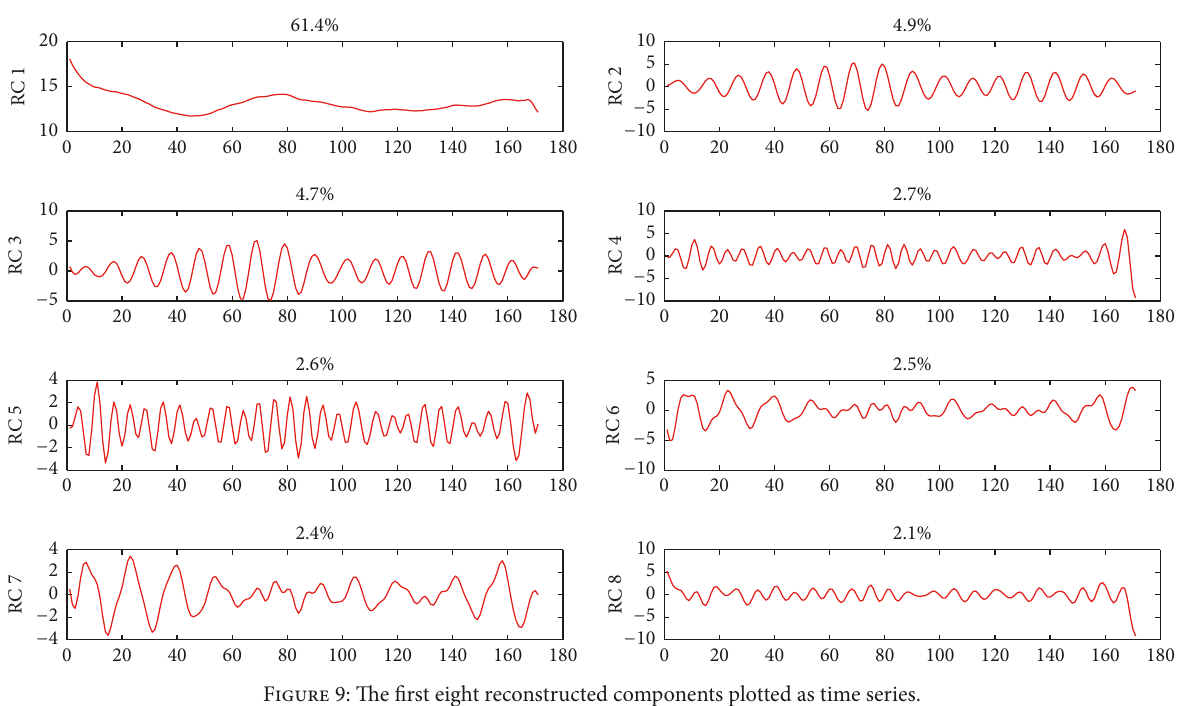
Figure 9: The first eight reconstructed components plotted as time series.